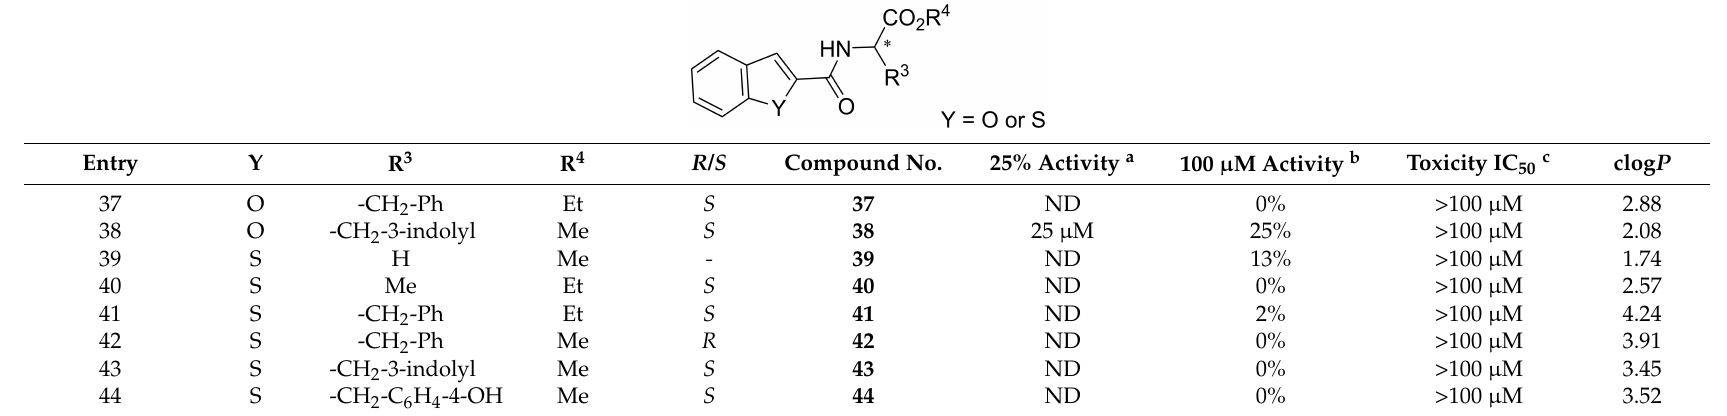
Table 2. Evaluation of HIF activity by benzofuran- and benzothiophene-2-carbonyl amino acid derivatives, their toxicity, and their partition